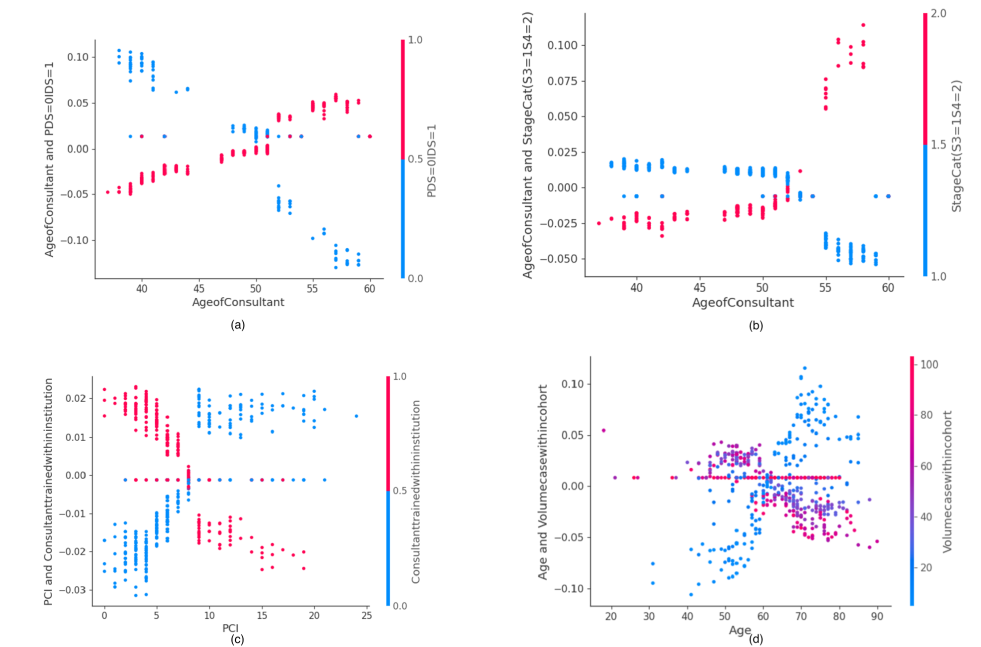
Figure 5. Examples of SHAP Value Interaction plots related to human factors: ( a ) Consultant age and timing of surgery, ( b ) Consultant age and stage, ( c ) PCI and site of consultant training, ( d ) Patient age and volume case within cohort. PCI, Peritoneal Carcinomatosis